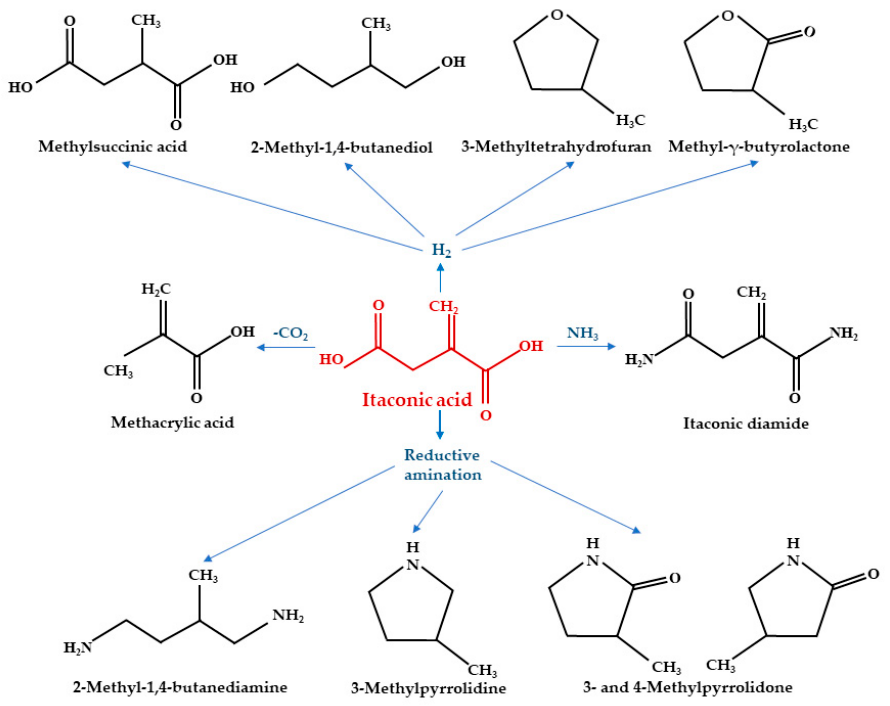
Figure 3. IA conversion into profitable derivatives.